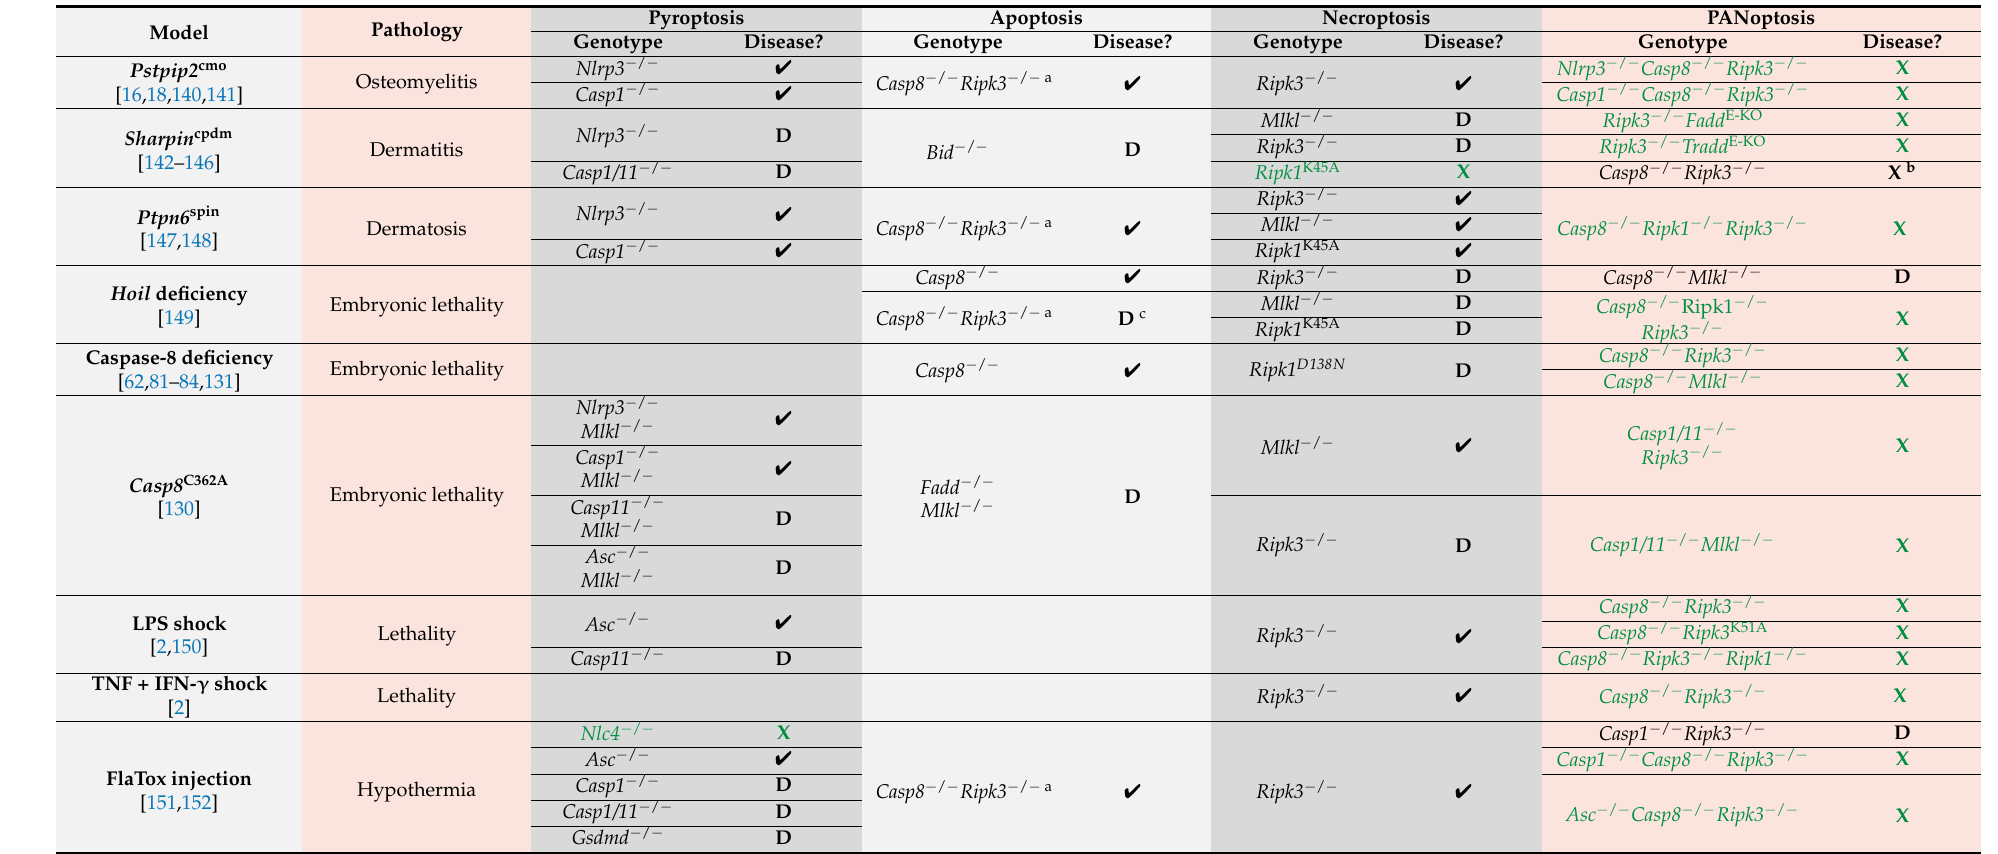
Table 2. Totality of cell death in disease